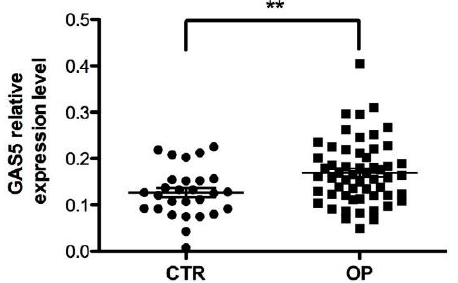
Figure 2. Serum expression level of GAS5 in OP patients. GAS5 expression level was analyzed in serum from 56 OP patients and 28 healthy controls. GAPDH mRNA level was used to normalize the relative amount of GAS5 and relative expression values are expressed as 2 −ΔCt . Individual data points represent the mean of duplicate assays for each sample. Statistical differences between OP and CTR groups were analyzed by non-parametric Mann–Whitney U -test. Error bars indicate mean ± standard error mean (s.e.m.) ** p < 0.01.